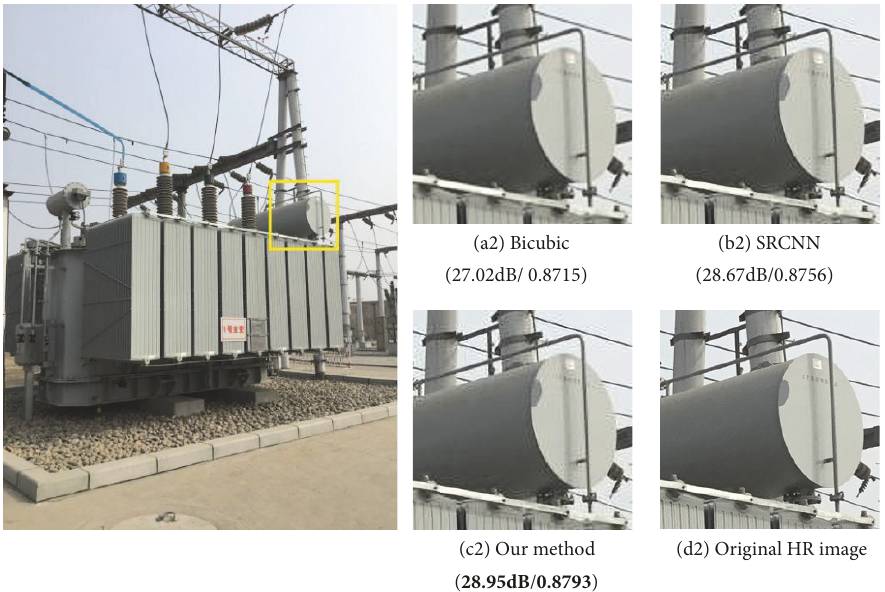
Figure 6: Simulated oil leaking in the transformer’s oil pillow.